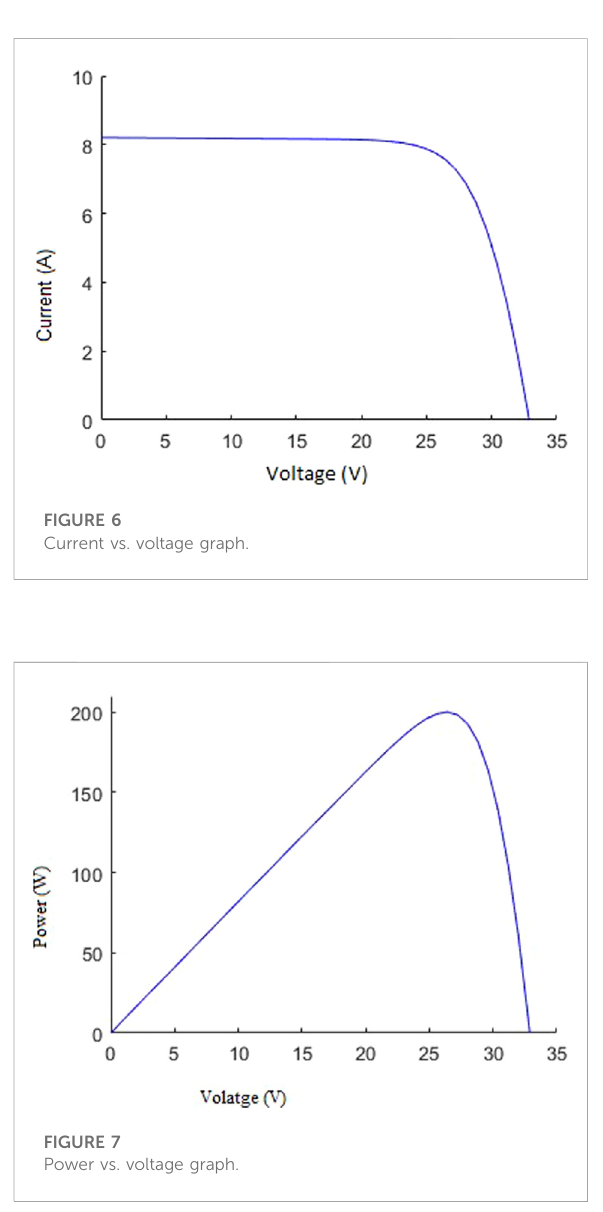
FIGURE 7 Power vs. voltage graph.